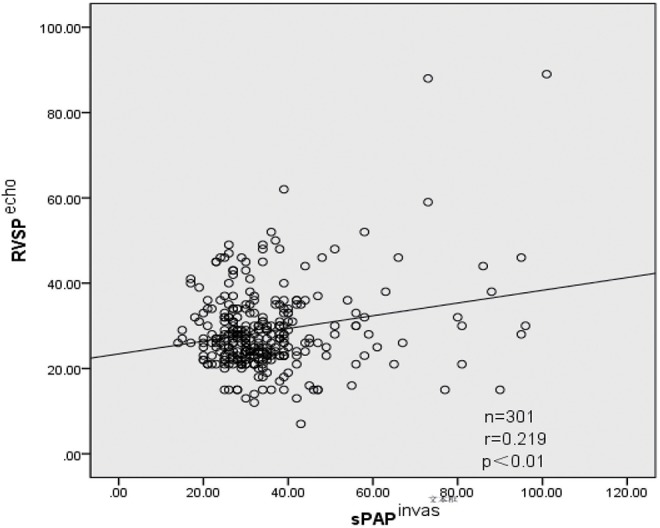
Relationship between RVSP estimated by D-ECHO and sPAP observed by RHC (r = 0.219, p < 0.01). Echo, measured by Doppler echocardiographic; invas, invasive measurement by right-heart catheterization; r, correlation coefficient (Pearson); sPAP, systolic pulmonary artery pressure; RVSP, right ventricular systolic pressure.